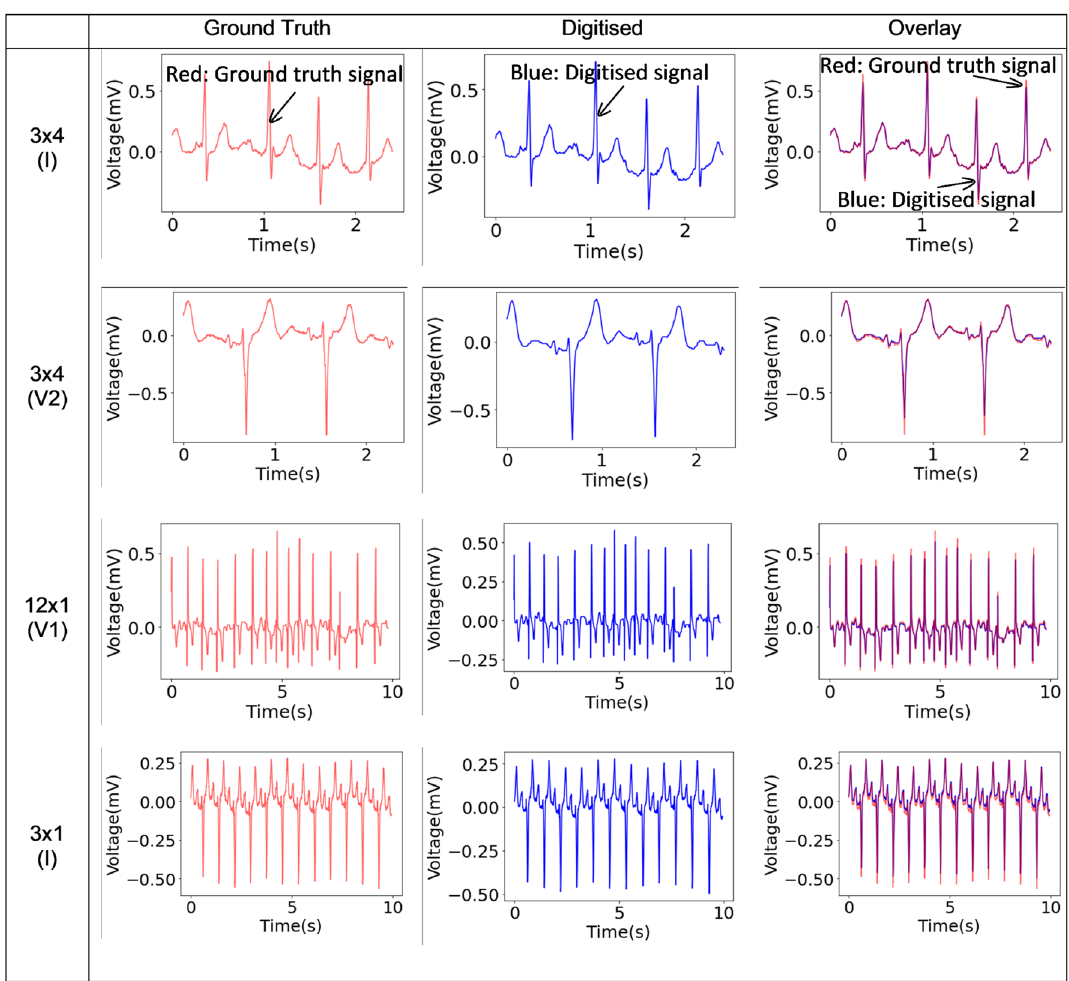
Figure 5. Digitisation results and ground truth comparison: ground truth original digital ECG signals (left) and digitised signals from images (centre) shown together with the overlay of both traces (right), for multiple ECG configurations. Ground truth signal is shown as red and digitised signal is shown as blue, the overlay of comparison plot shows two coloured signals overlapped. The overlay shows excellent correlation between the ground truth and digitised signals.